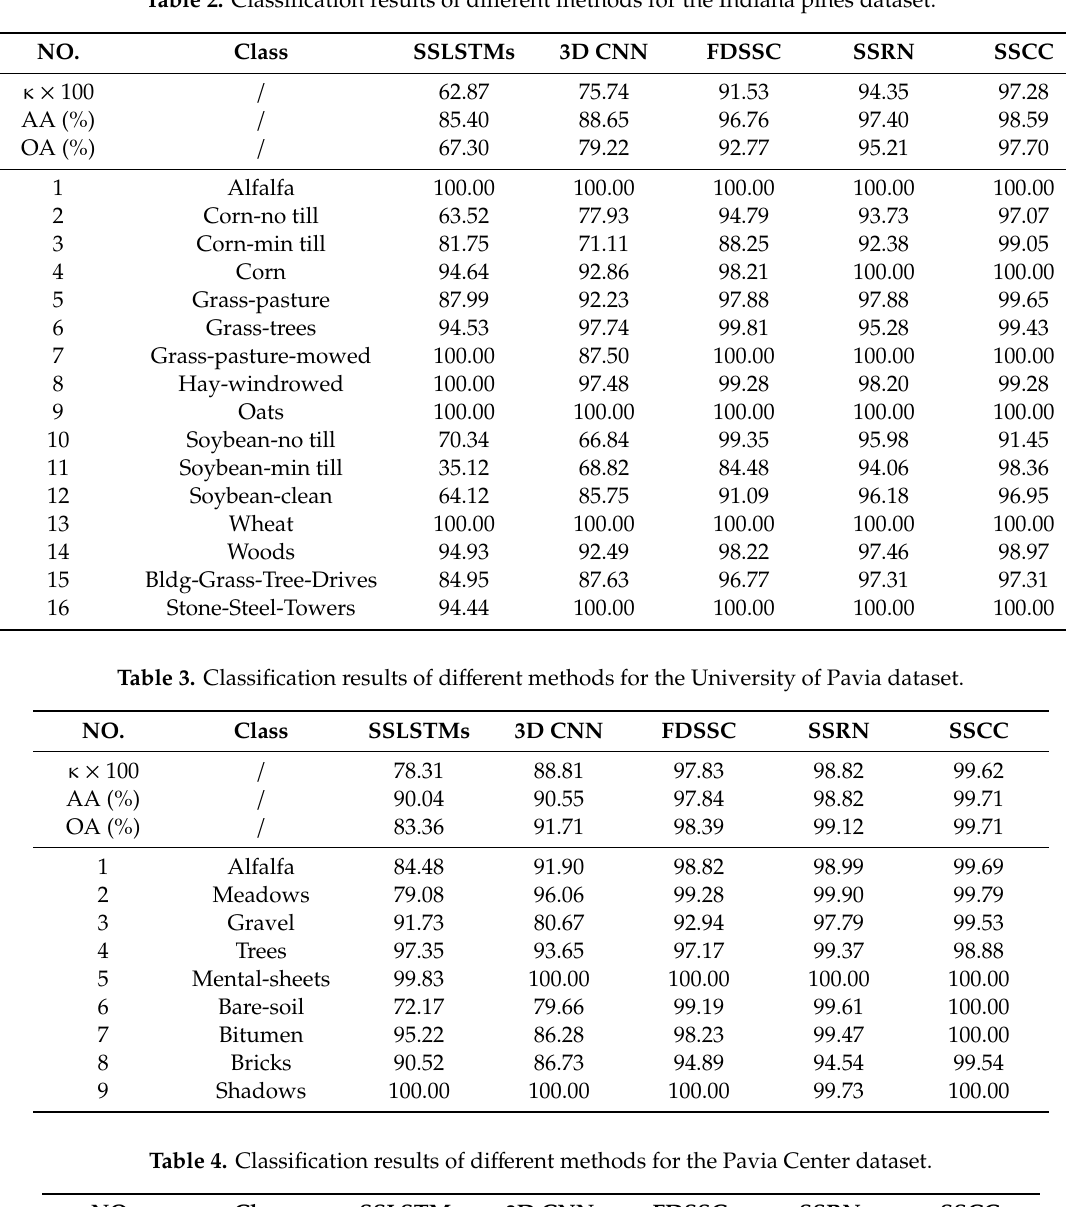
Table 2. Classification results of di ff erent methods for the Indiana pines dataset.